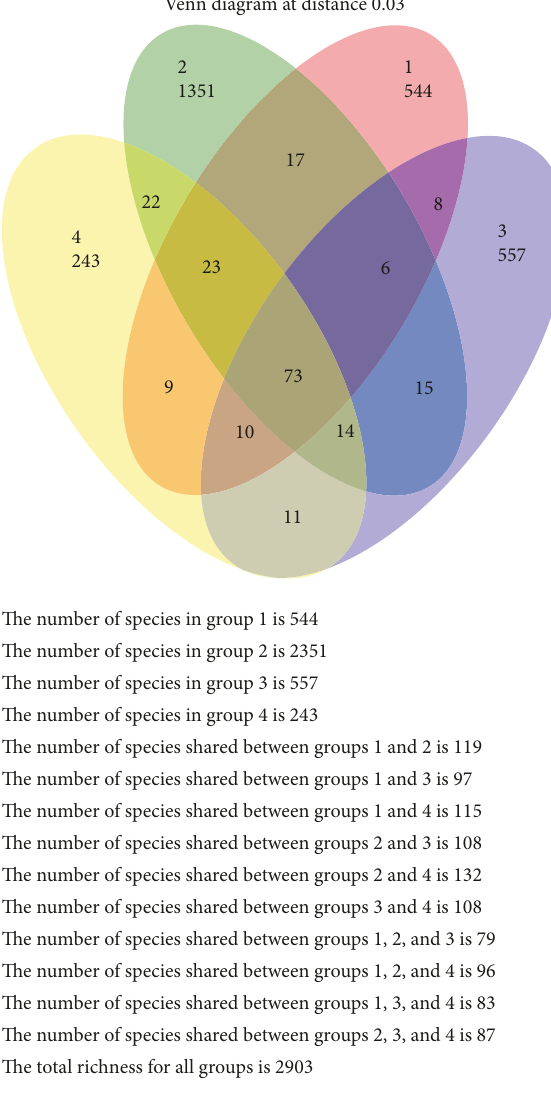
Figure 8: Venn diagram illustrated the number of shared OTUs according to four age groups at 97% similarity. Colored circles represented each age group and intersection part between circles represented the number of shared OTUs.